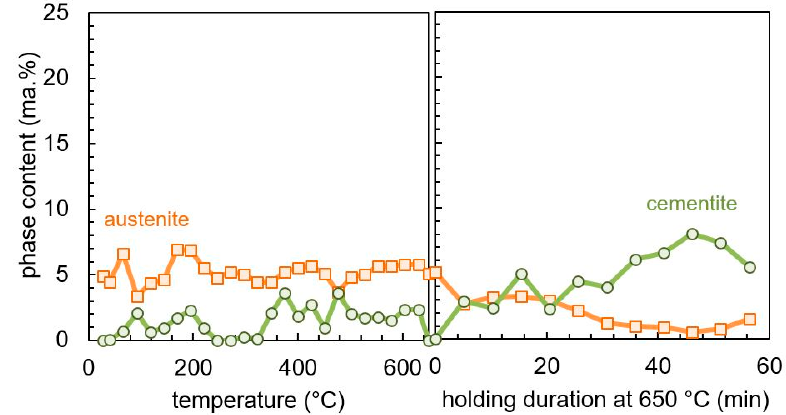
Figure 10. Measured microstructure evolution during tempering of SAE H13 during heating to 650 °C with 5 K min − 1 ( left ) and holding at 650 °C ( right ), determined by in-situ X-ray measurement.